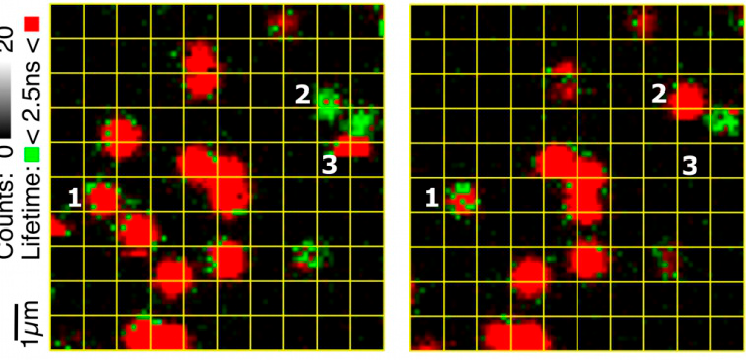
Figure 6. Example of switching between populations. The two images were taken of the same area of the glass surface carrying the Af-NiR-647N molecules immobilized in agarose with an interval of 10 min (left first). The grid (1 × 1 μ m) has been applied to facilitate comparing the positions of the molecules in the two images. Molecule 1 switches from population A to B while the opposite happens for molecule 2. A few molecules disappear in the course of time due to bleaching. For instance, in the left image a single-step photo-bleaching occurs for molecule 3 during the scan. Experimental conditions: 10